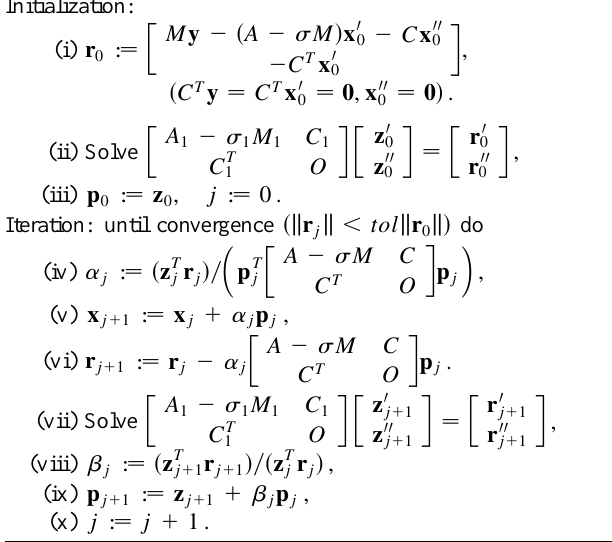
Algorithm 3. Preconditioned conjugate gradient method for the augmented linear system after simplifications.